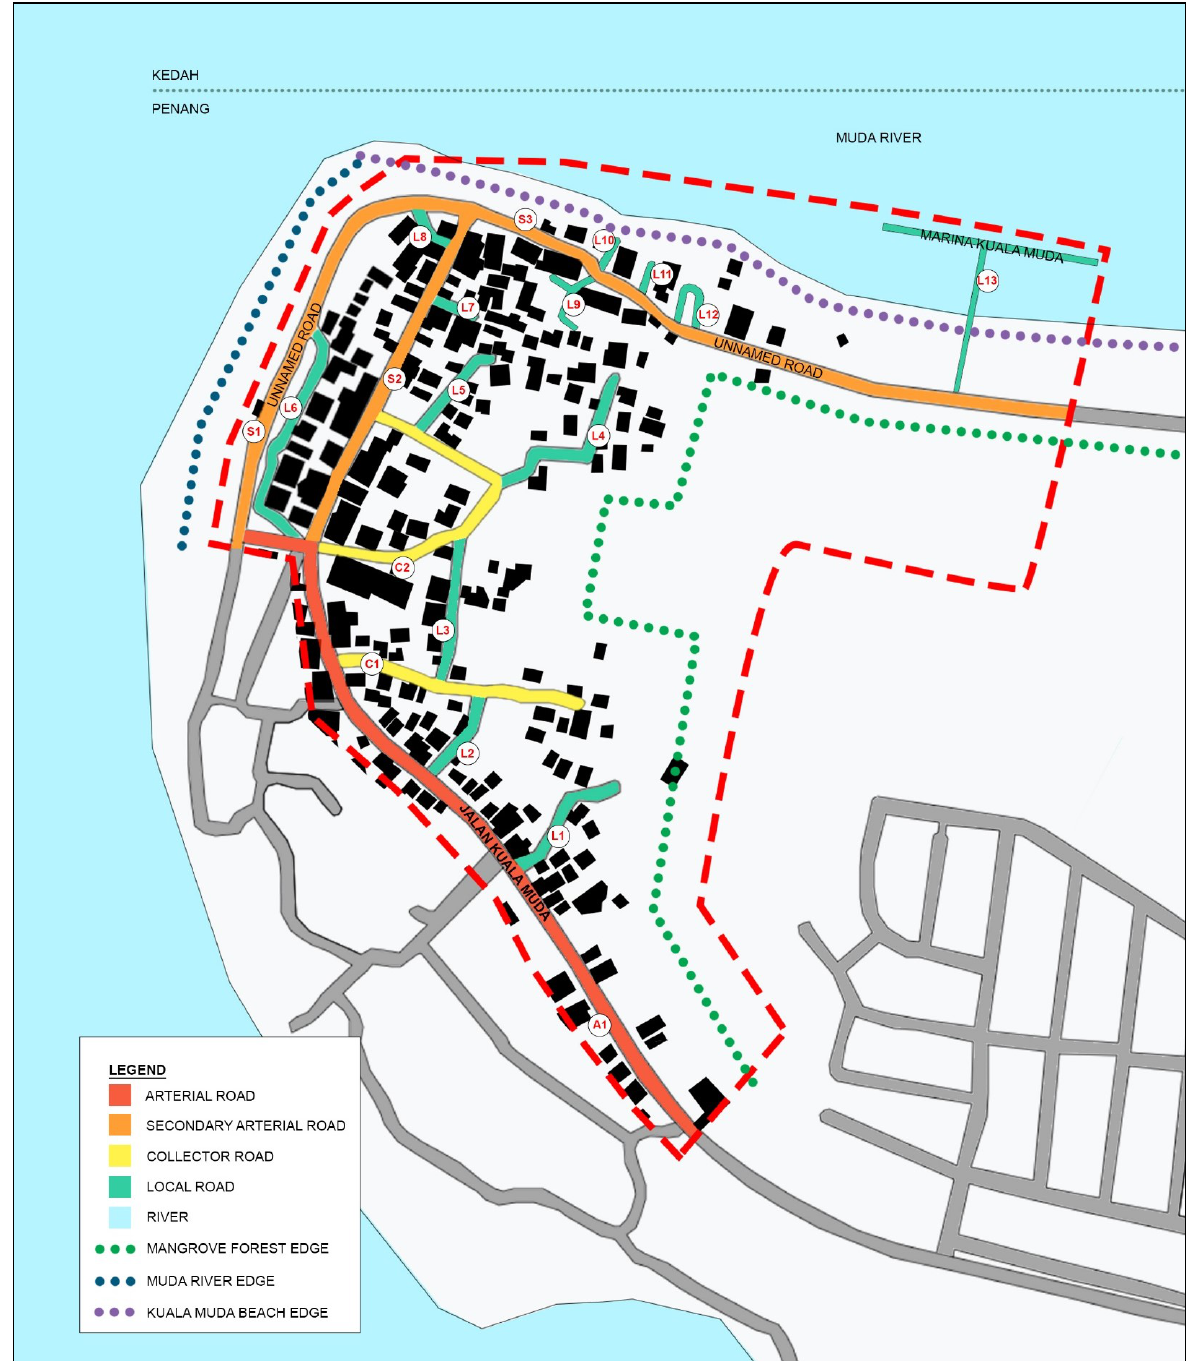
Figure 2. Paths and edges in Kuala Muda,